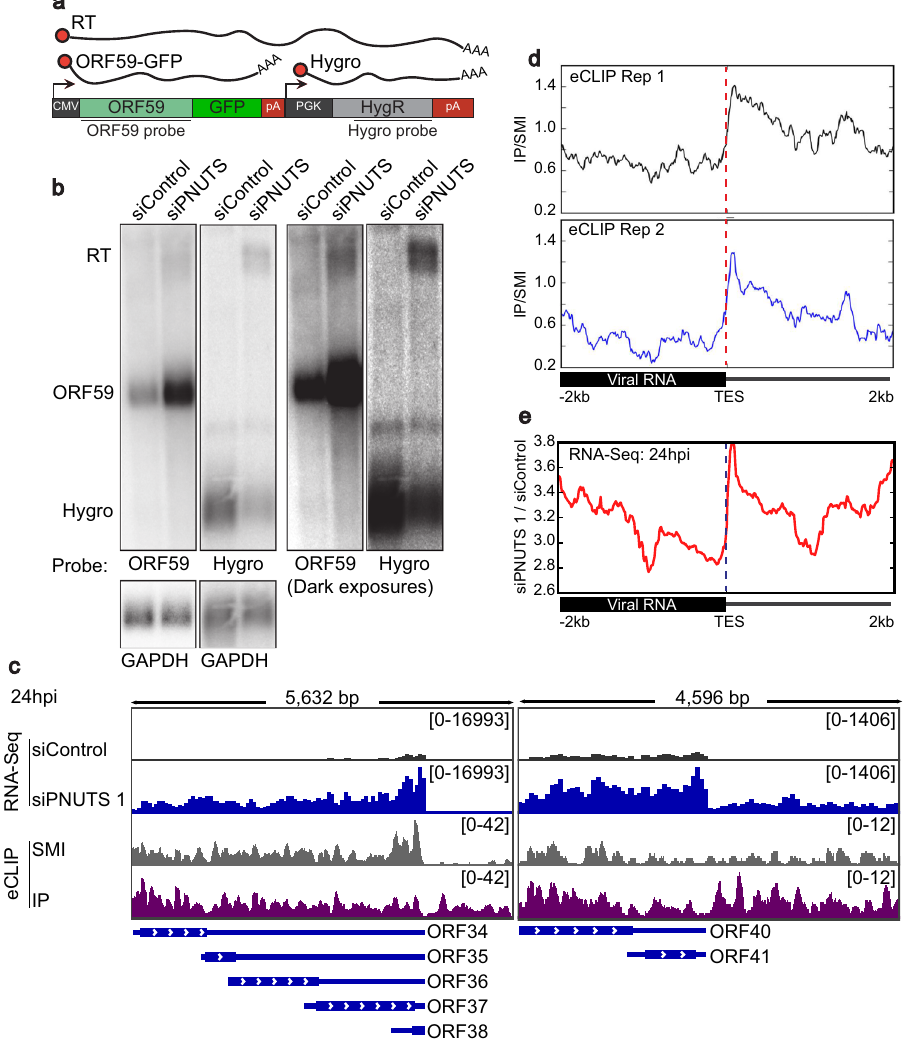
Fig.5|PNUTSbindstoKSHVRNAandsuppressesreadthroughtranscriptionin KSHV. a Schematic of integrated reporter construct with northern probes and predicted RNA species listed. b Northern blots of polyA-selected mRNA from HCT116reportercells,usingacocktailofbothPNUTSsiRNAs.Theblotsontheright are overexposed versions of the same blots on the left. c Representative IGV browser images of KSHV gene coverage from RNA-Seq and PNUTS eCLIP in iSLK cells at 24hpi. Dark gray is siControl, dark blue is siPNUTS. Light gray is the size-